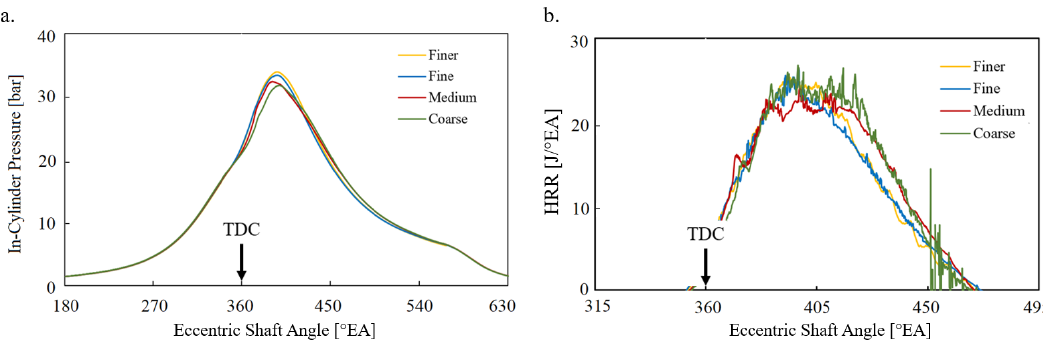
Figure 8. Mesh independence study of; ( a ) in-cylinder pressure, ( b ) HRR results.